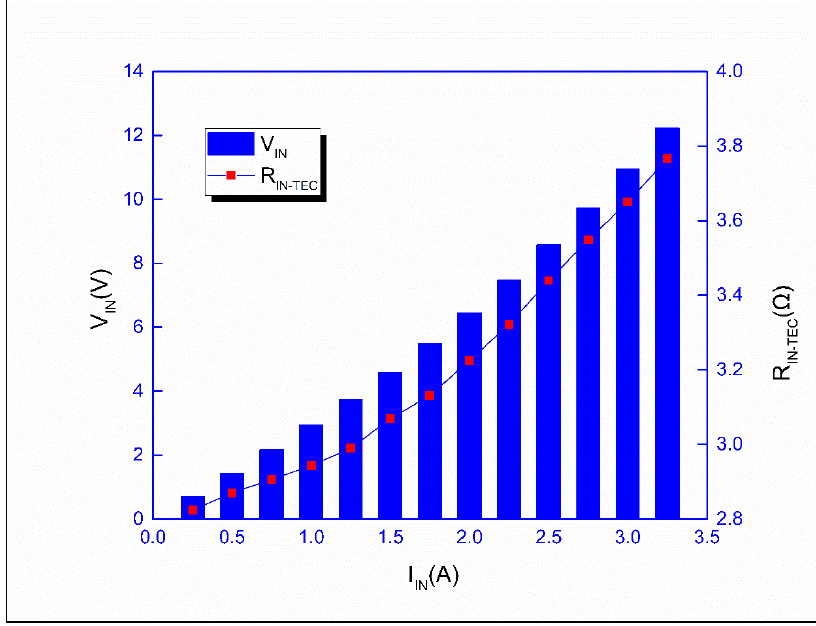
Figure 4. Dependence of V IN , Rl oad on input current.